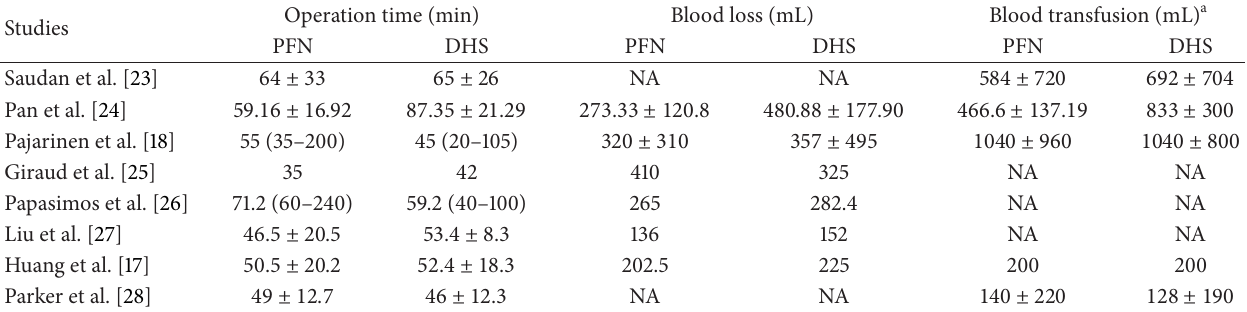
Table 3: Intraoperative outcomes of the two groups.